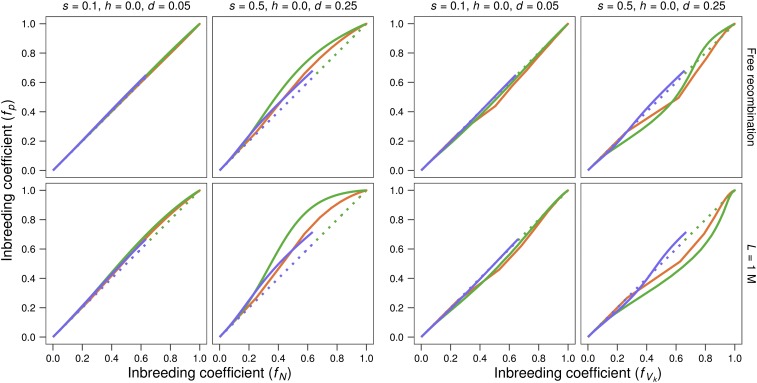
Average pedigree inbreeding plotted against inbreeding expected just from the census or taking into account the variance of gametic contributions. Per-generation average inbreeding obtained from pedigrees in the lines (fp) represented for two different deleterious effects (s) with completely recessive gene action (h = 0), and assuming free recombination or a genome length of L = 1 Morgan. Results are plotted against the inbreeding expected from the census (fN) in the four left panels, and against the inbreeding expected taking into account the observed variance of gametic contributions (fVk) in the four right panels. Red: N = 2; green: N = 10; blue: N = 50. Solid lines: lines maintained under the MSD scenario. Dotted lines: lines maintained under the MD scenario.